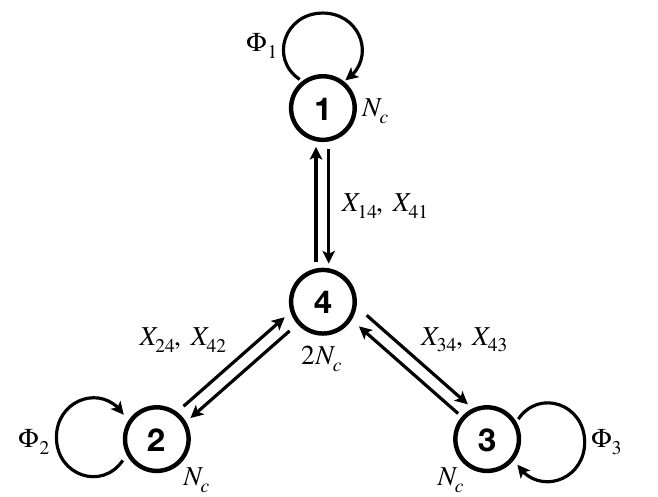
Figure 2 . Quiver for the non-toric phase of C 3 / Z 2 × Z 2 . Observe that the fields Φ 1 , 2 , 3 in the figure are associated to bifundamental reducible